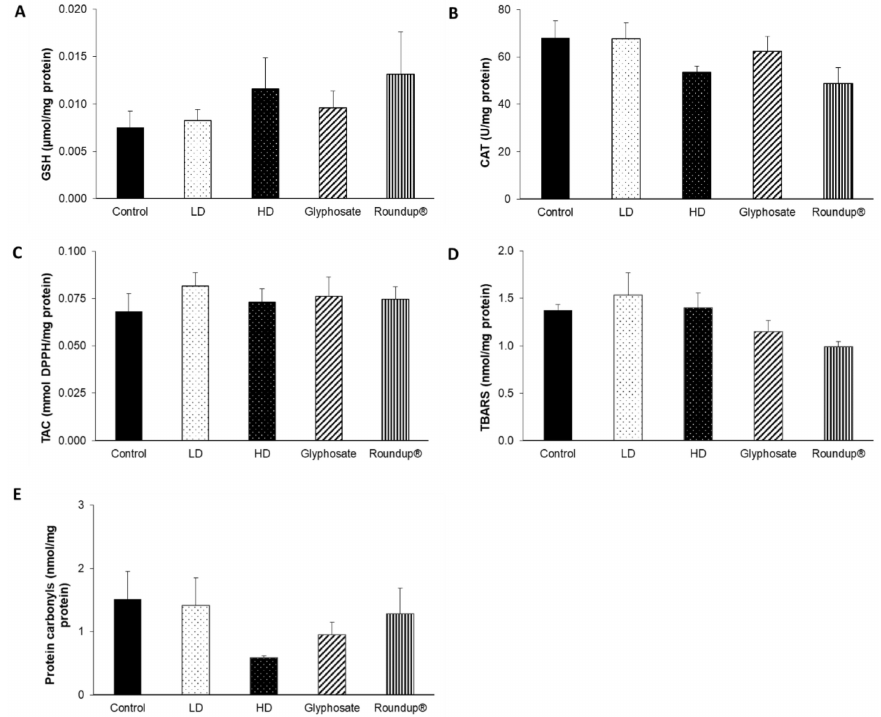
Figure 10. The effects of 12-month exposure of New Zealand rabbits to the EDs mixture, glyphosate, and Roundup ® on thyroid gland GSH concentration ( A ), CAT activity ( B ), TAC levels ( C ), TBARS levels ( D ), and protein carbonyls concentration ( E